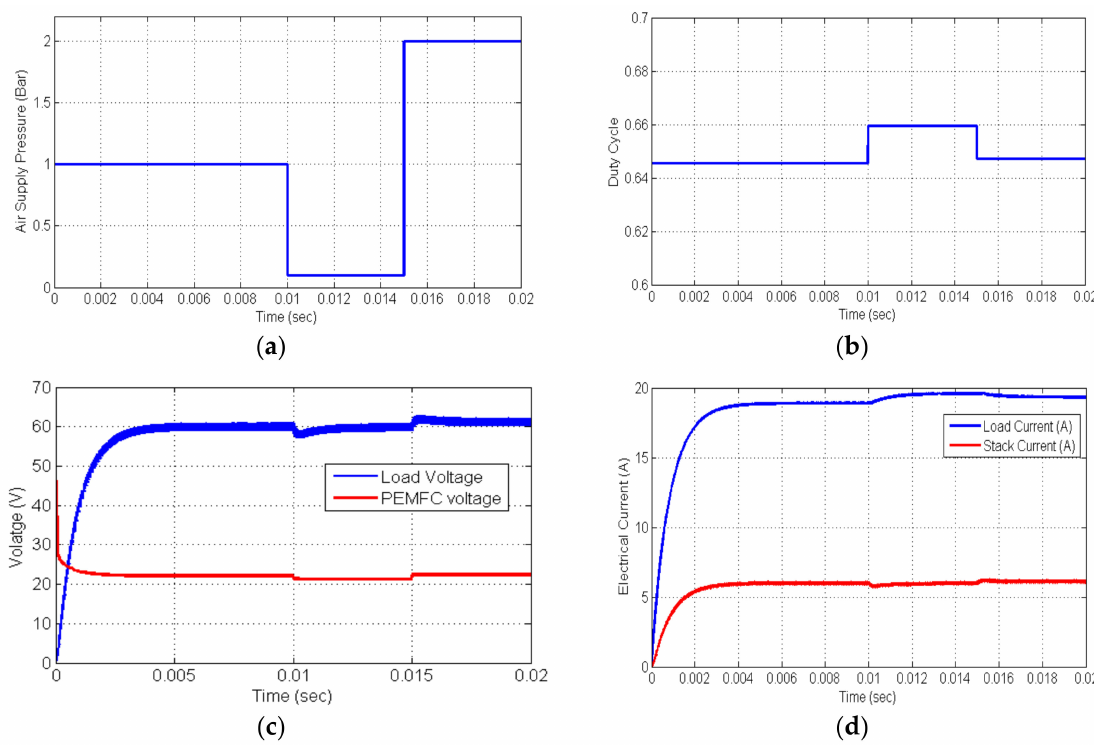
Figure 15. ( a ) Variation of the air supply pressure, ( b ) Variation of the duty cycle, ( c ) voltage variation, ( d ) current variation.